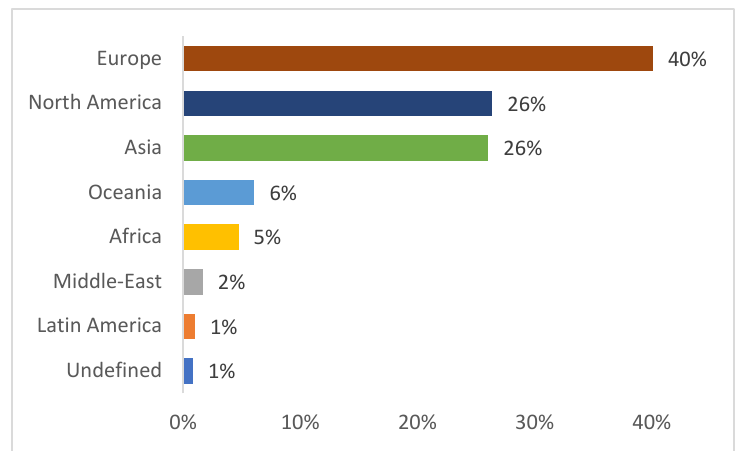
Figure 1. Annual distribution of the paper published on weeds–mycorrhiza interaction from 1975 to September 2022.